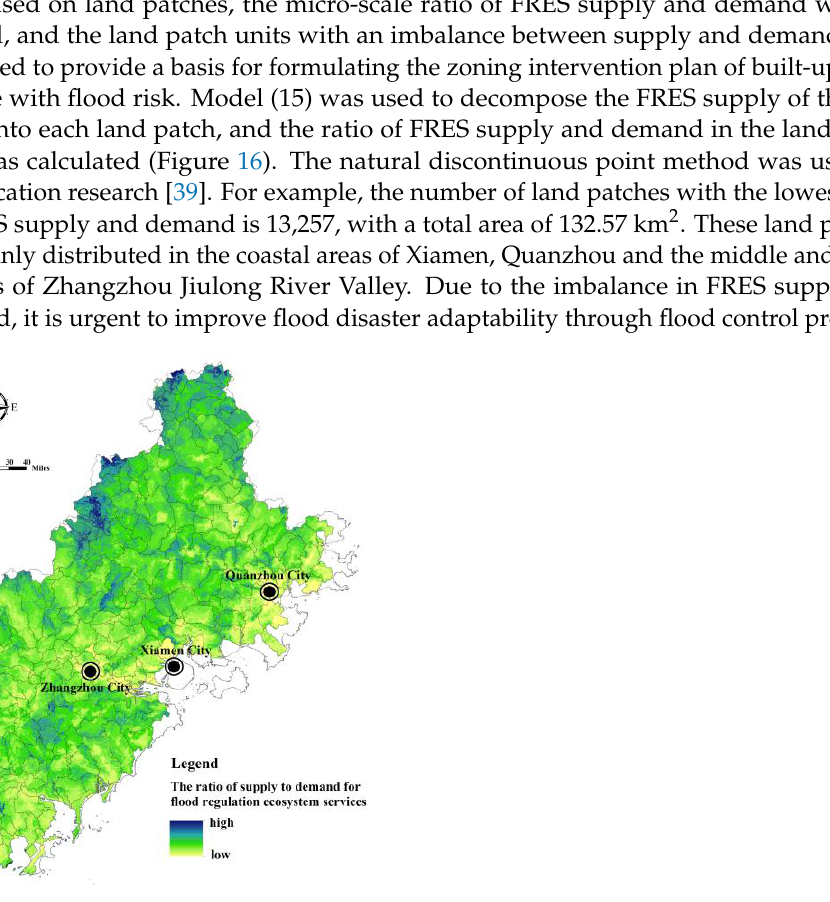
Figure 16. Analysis of the ratio between FRES supply and demand in Fujian Delta based on land patch.